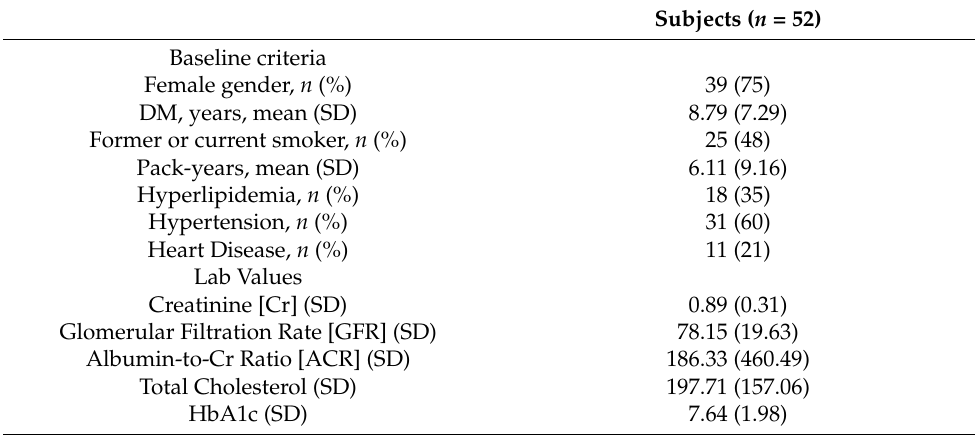
Table 1. Patient Demographics and Clinical